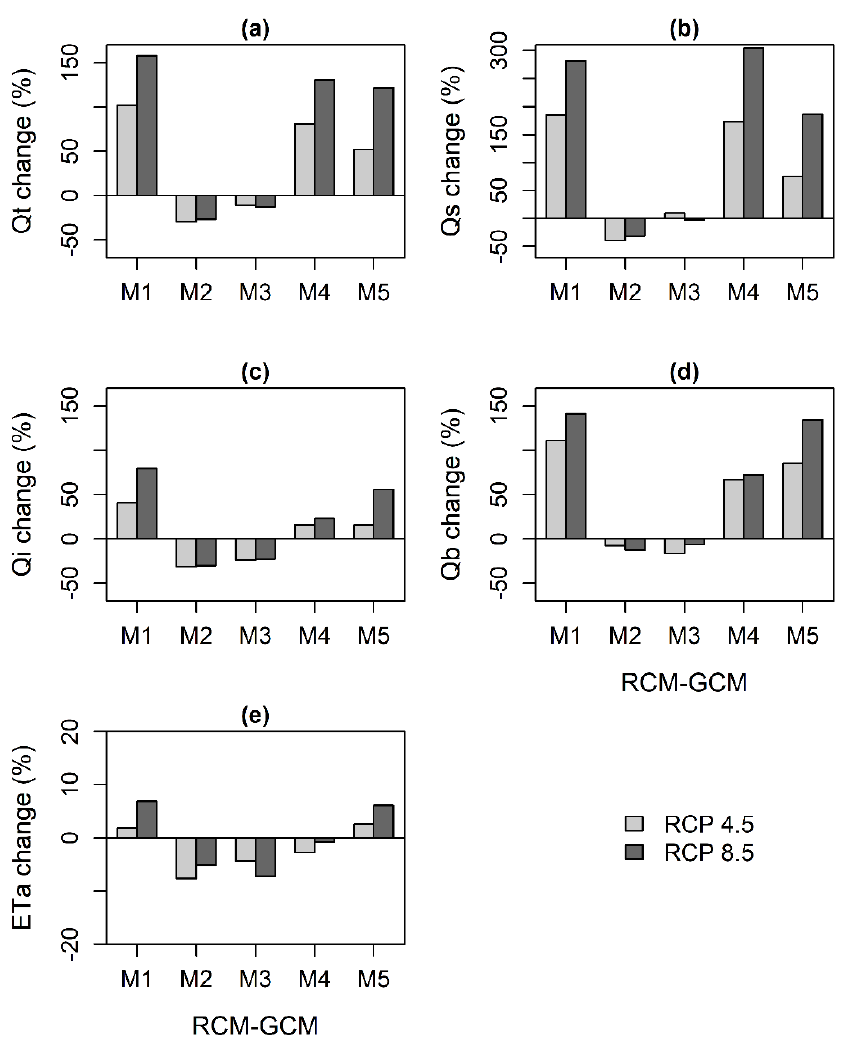
Figure 10. Annual change for the period of 2021–2050 (LULC 2030) of total runoff (Qt), surface runoff (Qs), interflow (Qi), base flow (Qb), and actual evapotranspiration (ETa) compared to the period of 1971–2000 (LULC 2013): M1 : CCLM-CNRM; M2 : CCLM-EARTH; M3 : CCLM-ESM; M4 : HIRHAM-NorESM; and M5 : RACMO-EARTH. ( a ): total runoff; ( b ): surface runoff; ( c ): interflow; ( d ): base flow; ( e ): actual evapotranspiration.